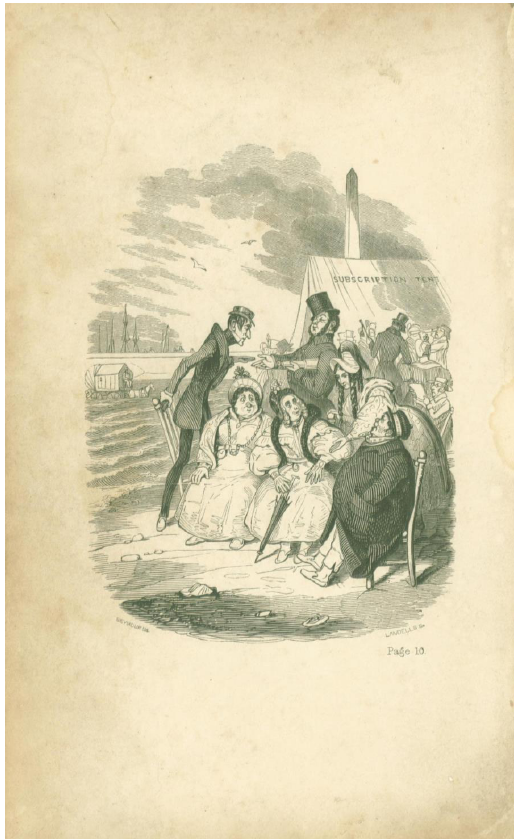
Fig. 4 Title page and frontispiece for the New Comic Magazine (London: Marshall, n.d. [?1832]) advertising Seymour’s contributions. The frontispiece resembles a coarse and rather grotesque first attempt at the cover illustration for the part issue of Pickwick four years later.